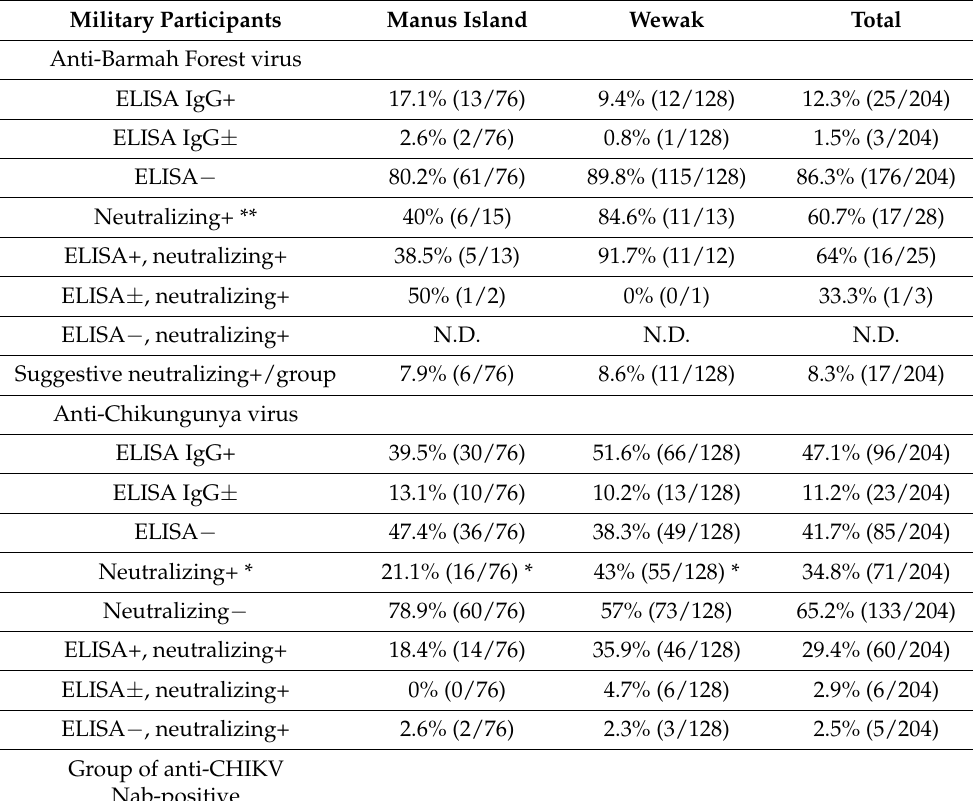
Table 2. Prevalence of anti-Barmah Forest virus, anti-Chikungunya virus and anti-Ross River virus antibodies, observed in 204 Papua New Guinea military participants in this study in